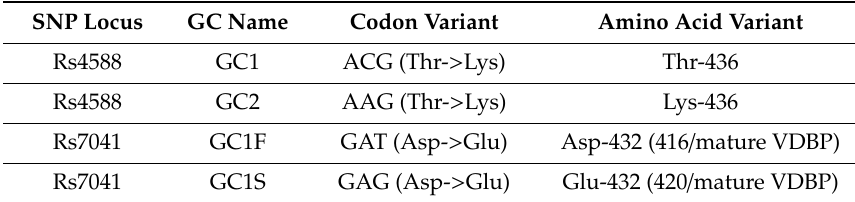
Table 1. Characteristics of vitamin D binding protein (VDBP). VDBP polymorphisms (based on Bouillon 2020 [53])